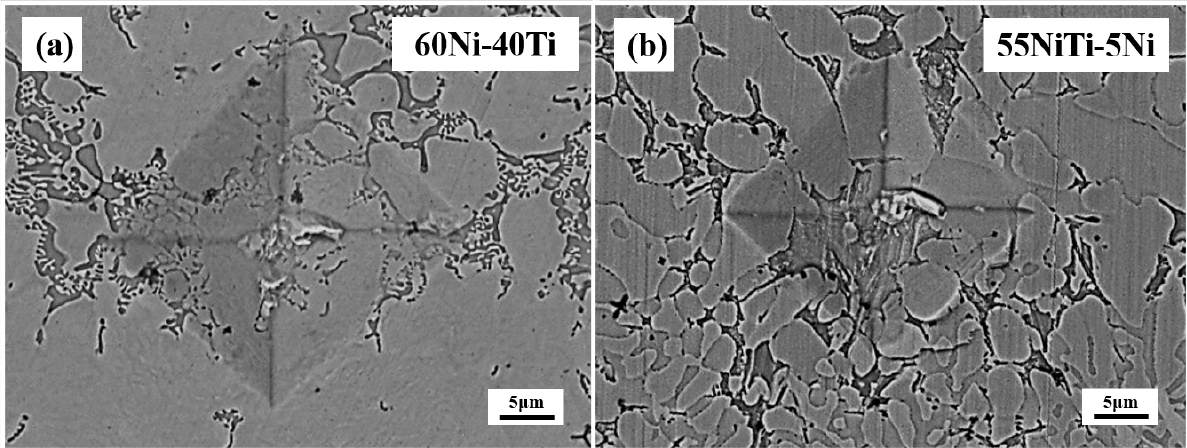
Figure 9. Microhardness indentation of coatings in the bonding zone: ( a ) 60Ni-40Ti; ( b ) 55NiTi-5Ni.